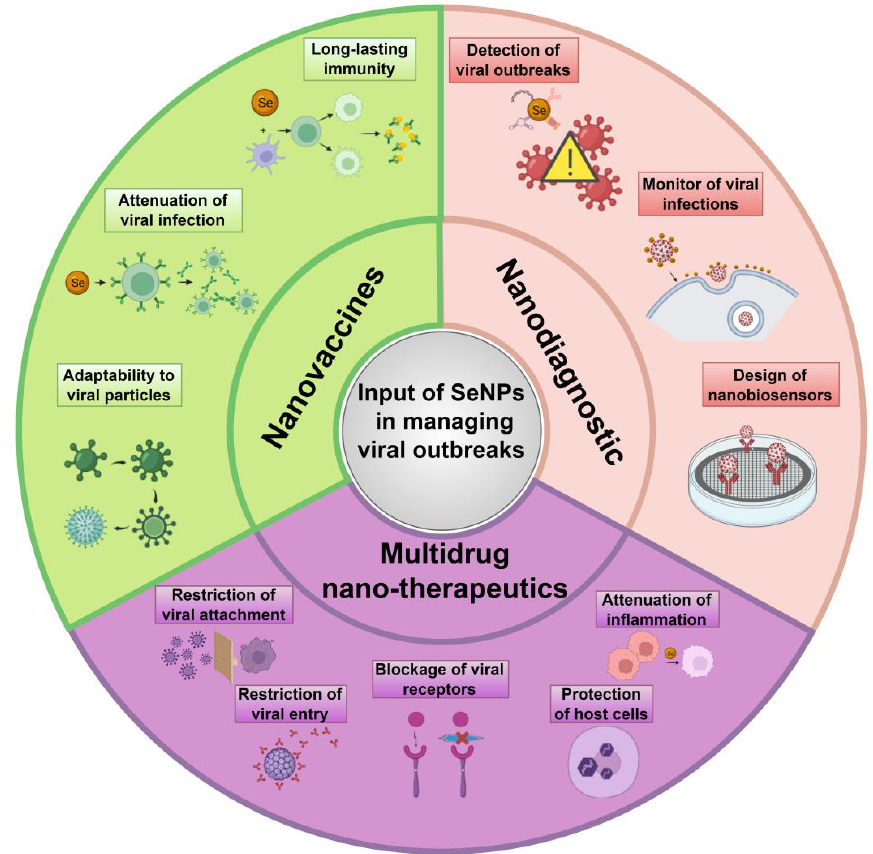
Figure 6. Biomedical application of SeNPs against viral